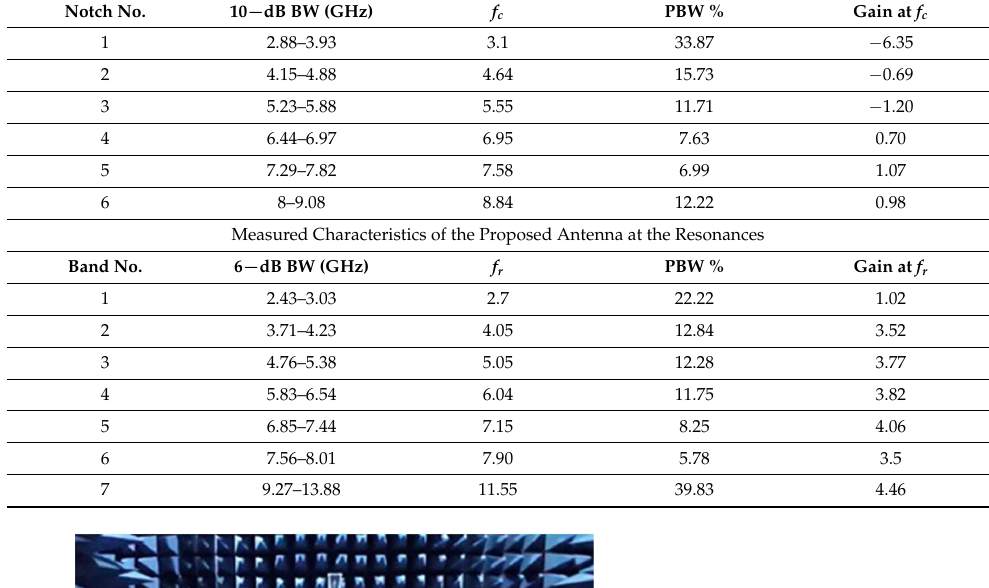
Table 2. Measured characteristics of the proposed antenna at the notches.